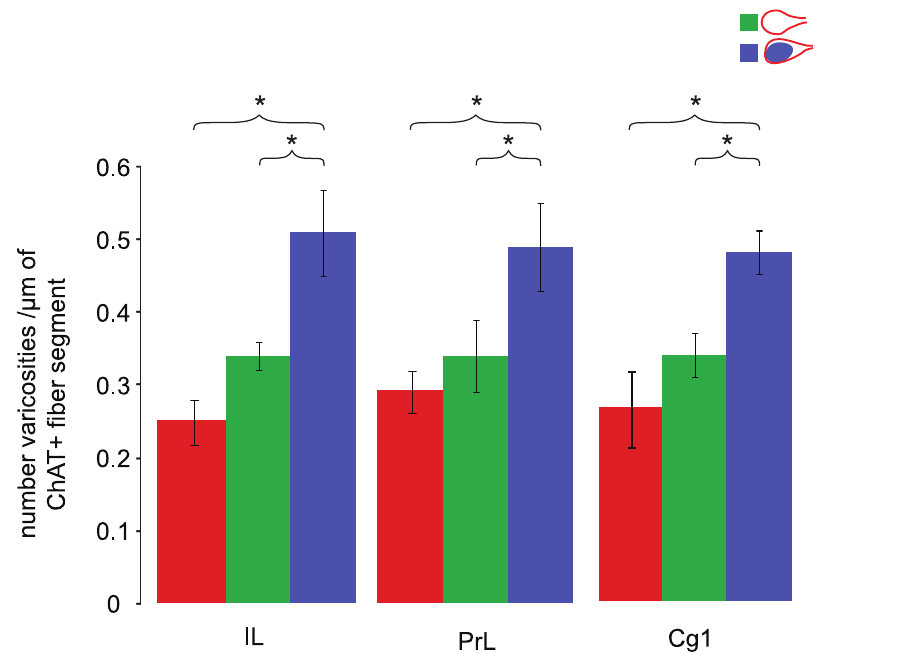
Figure 4. ChAT + varicosities density on fiber segments within microproximity of activated or nonactivated pyramidal cells. Within the visual/HDB stimulation group, the density of ChAT + varicosities on fiber segments within microproximity of nonactivated cells (green bars) was lower than on fiber segments within microproximity of activated pyramidal cells (blue bars) in layer V of every subregion of mPFC investigated. In contrast, the density of ChAT + varicosities fiber segments within microproximity of nonactivated cells in the control group (red bars) was not significantly different from those within microproximity of nonactivated cells in the visual/HDB stimulation group, but significantly lower than those within microproximity of activated pyramidal cells in the visual/HDB stimulation. Symbol * indicate significant difference in the density of ChAT + varicosities on fiber segments within microproximity of activated pyramidal cells compared to those within microproximity of nonactivated pyramidal cells (p # 0.05, Mann-Whitney U test, two-tailed). Abbreviations: Cg1: cingulate cortex; ChAT: choline acetyltransferase; IL: infralimbic cortex; PrL: prelimbic cortex.